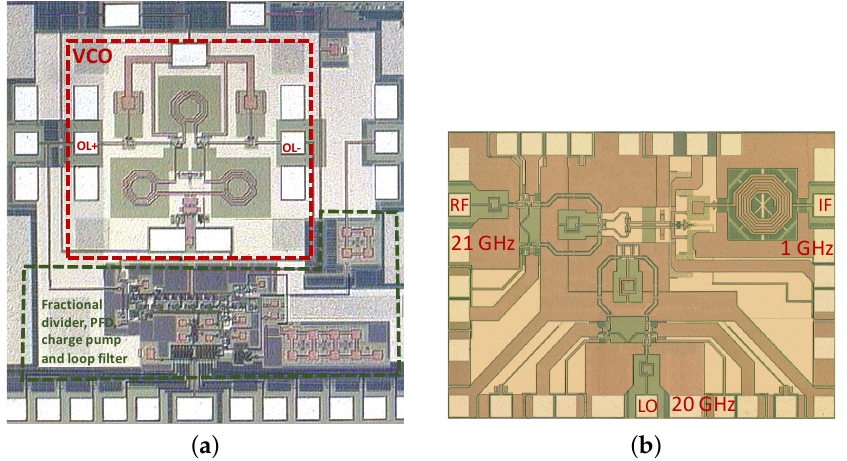
Figure 2. Microphotographs of: ( a ) a 20GHz PLL (LO) based on a push-push differential VCO and using a fractional digital divider, and ( b ) a 21GHz (RF) to 1GHz (IF) mixer. These circuits have been designed by the authors from LAAS-CNRS and developed with BiCMOS technologies from ST-Microelectronics (BiCMOS 7RF),